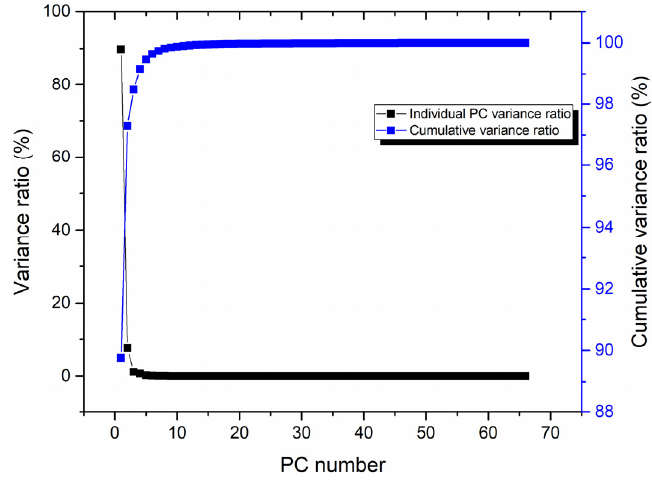
Figure 3. Variance ratio of each PC and cumulative variance ratio.